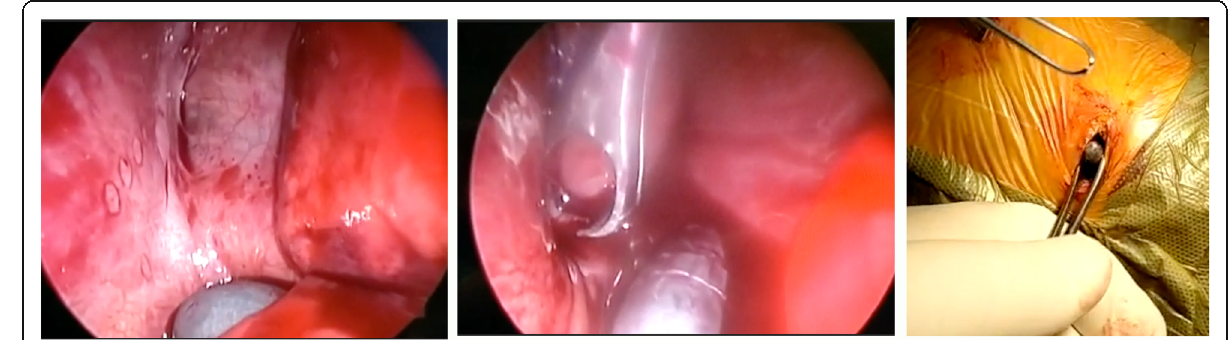
Fig. 3 Thoracoscopic removal of the